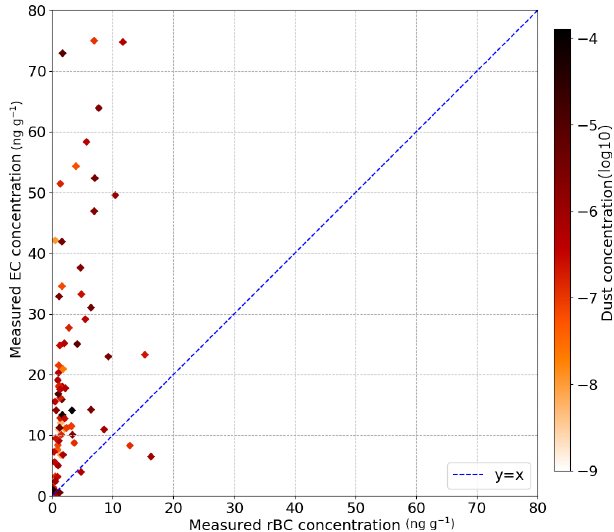
Figure 4. Comparison between EC measurements and rBC mea- surements for all available measurements over the two snow sea- sons. As the vertical resolution of rBC measurements is higher than for EC measurements, the rBC concentration is computed as the average of all rBC measurements weighted by snow density in the corresponding EC